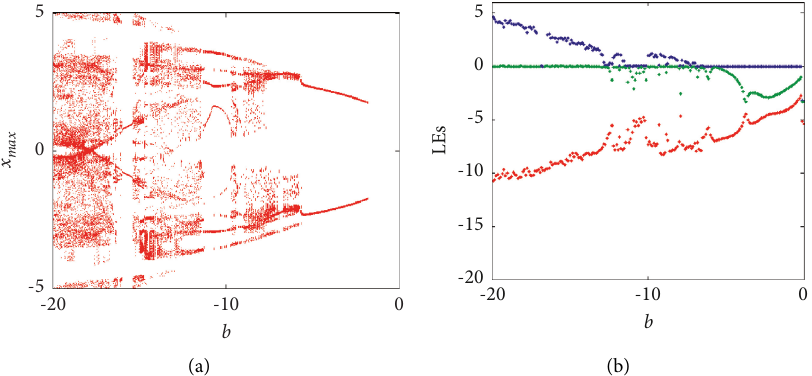
Figure 13: (a) The diagram of bifurcation. (b) Lyapunov exponents of system (4) when b ∈ (− 20 , 0 ) according to the other system parameter a � 1, the incommensurate fractional order [ q